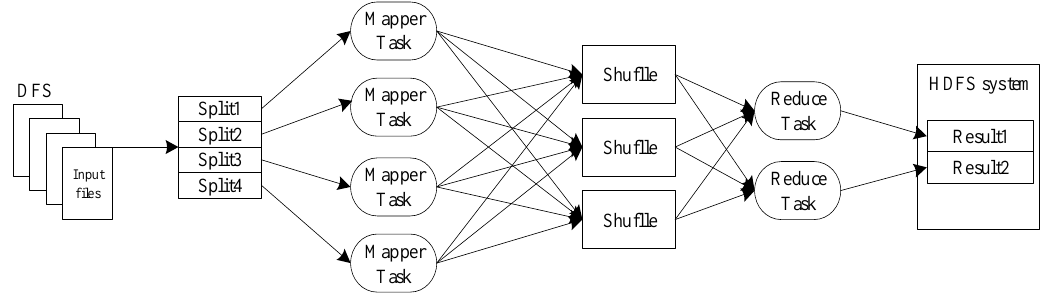
Figure 1. MapReduce working principle.